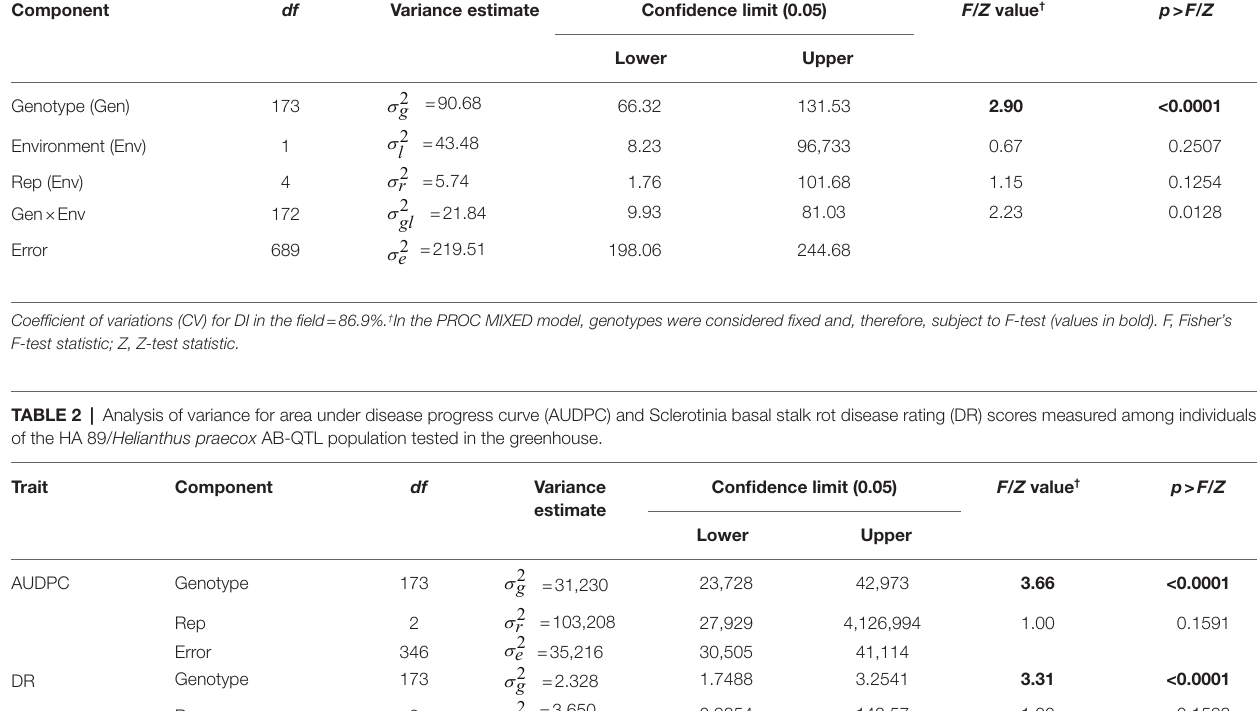
TABLE 1 | Combined analysis of variance for Sclerotinia basal stalk rot disease incidence scores among individuals of the HA 89/ Helianthus praecox AB-QTL population tested at Carrington, ND during 2017–2018. Component df Variance estimate